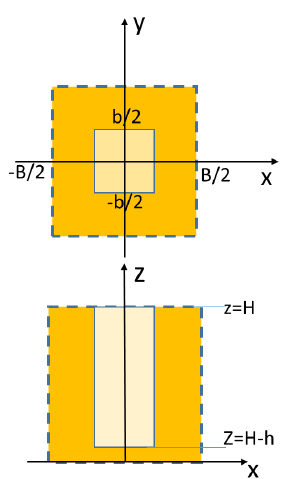
Figure 4. Definition of the coordinate system.